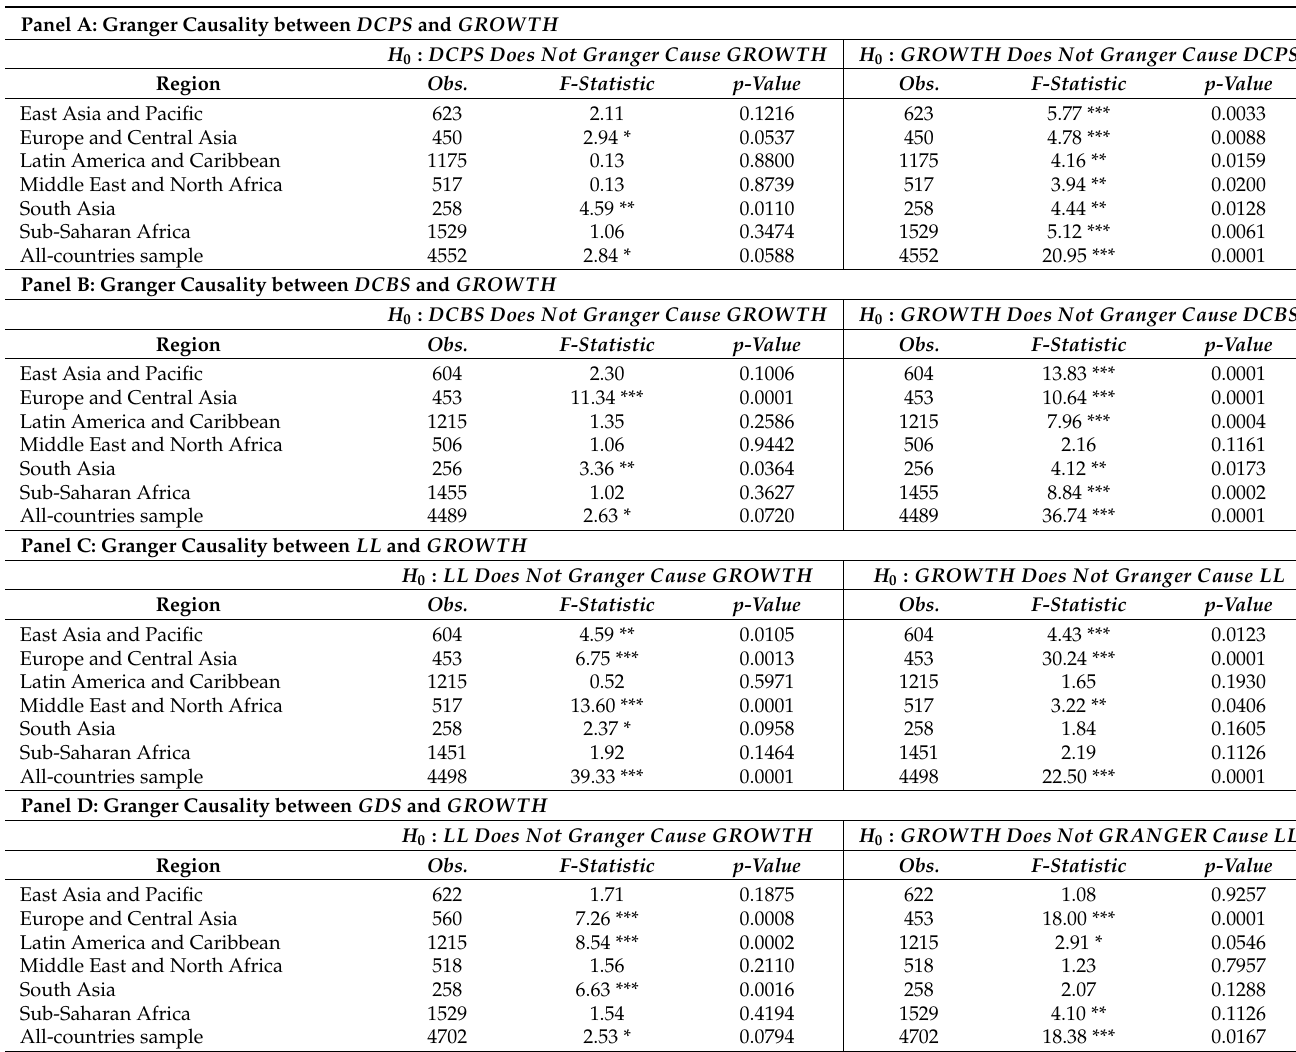
Table 4. Panel Granger causality